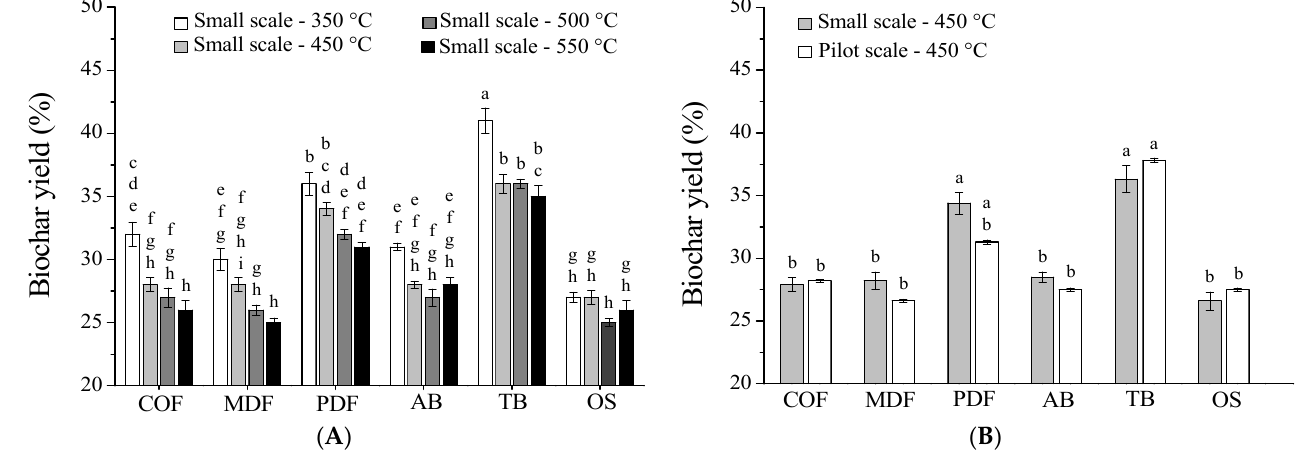
Figure 1. Biochar yield in function of the pyrolysis temperature ( A ), and comparison between lab-scale and pilot-scale reactor (T = 450 °C) ( B ) [30]. Means with different letters indicate a statistically significant difference (Tukey’s HSD, p < 0.05). COF = coffee husks, MDF = medium-density fiberboard, PDF = palm date fronds, AB = AB wood waste, TB = tree bark, and OS = olive stones. The lowercase letters above the columns are presented to compare different columns to each other. Columns with the same letter are not statistically different from each other, while columns with differing letters are statistically different from each other.